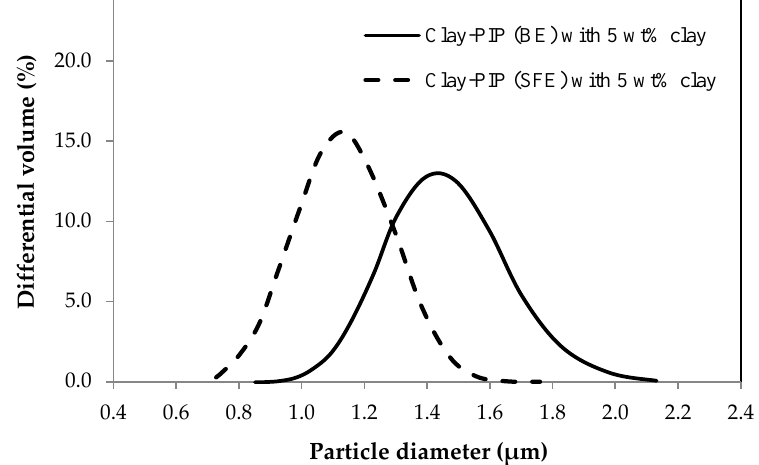
Figure 1. Real-time monitoring data of the internal reactor pressure as a function of reaction time of synthesizing Clay-PIP latexes through batch (BE) and starve-fed (SFE) emulsion polymerization